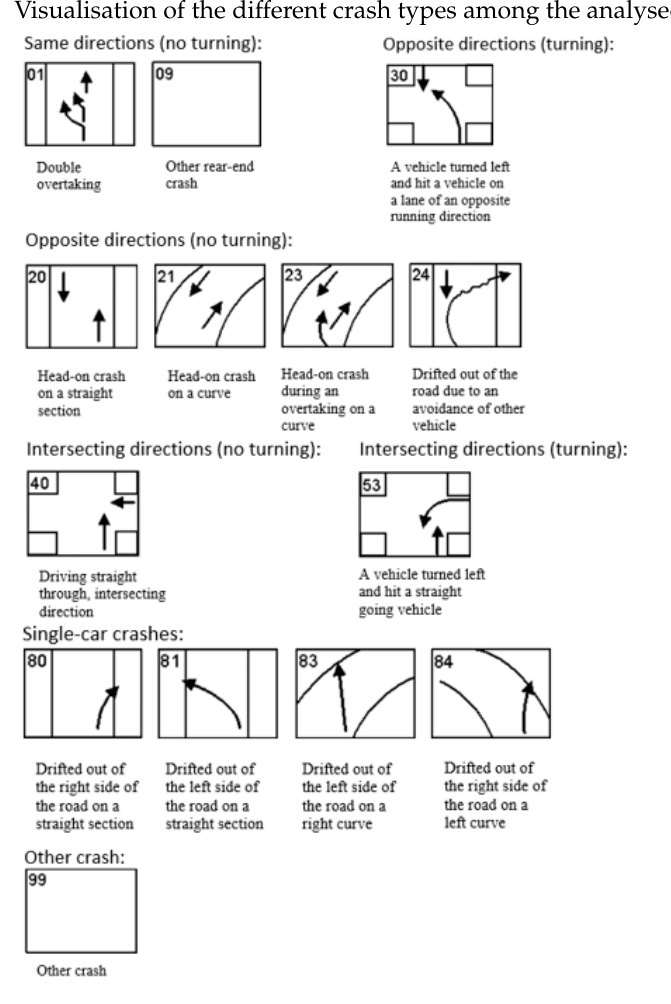
Figure A1. Visualisation of the different crash types among the analysed crashes.